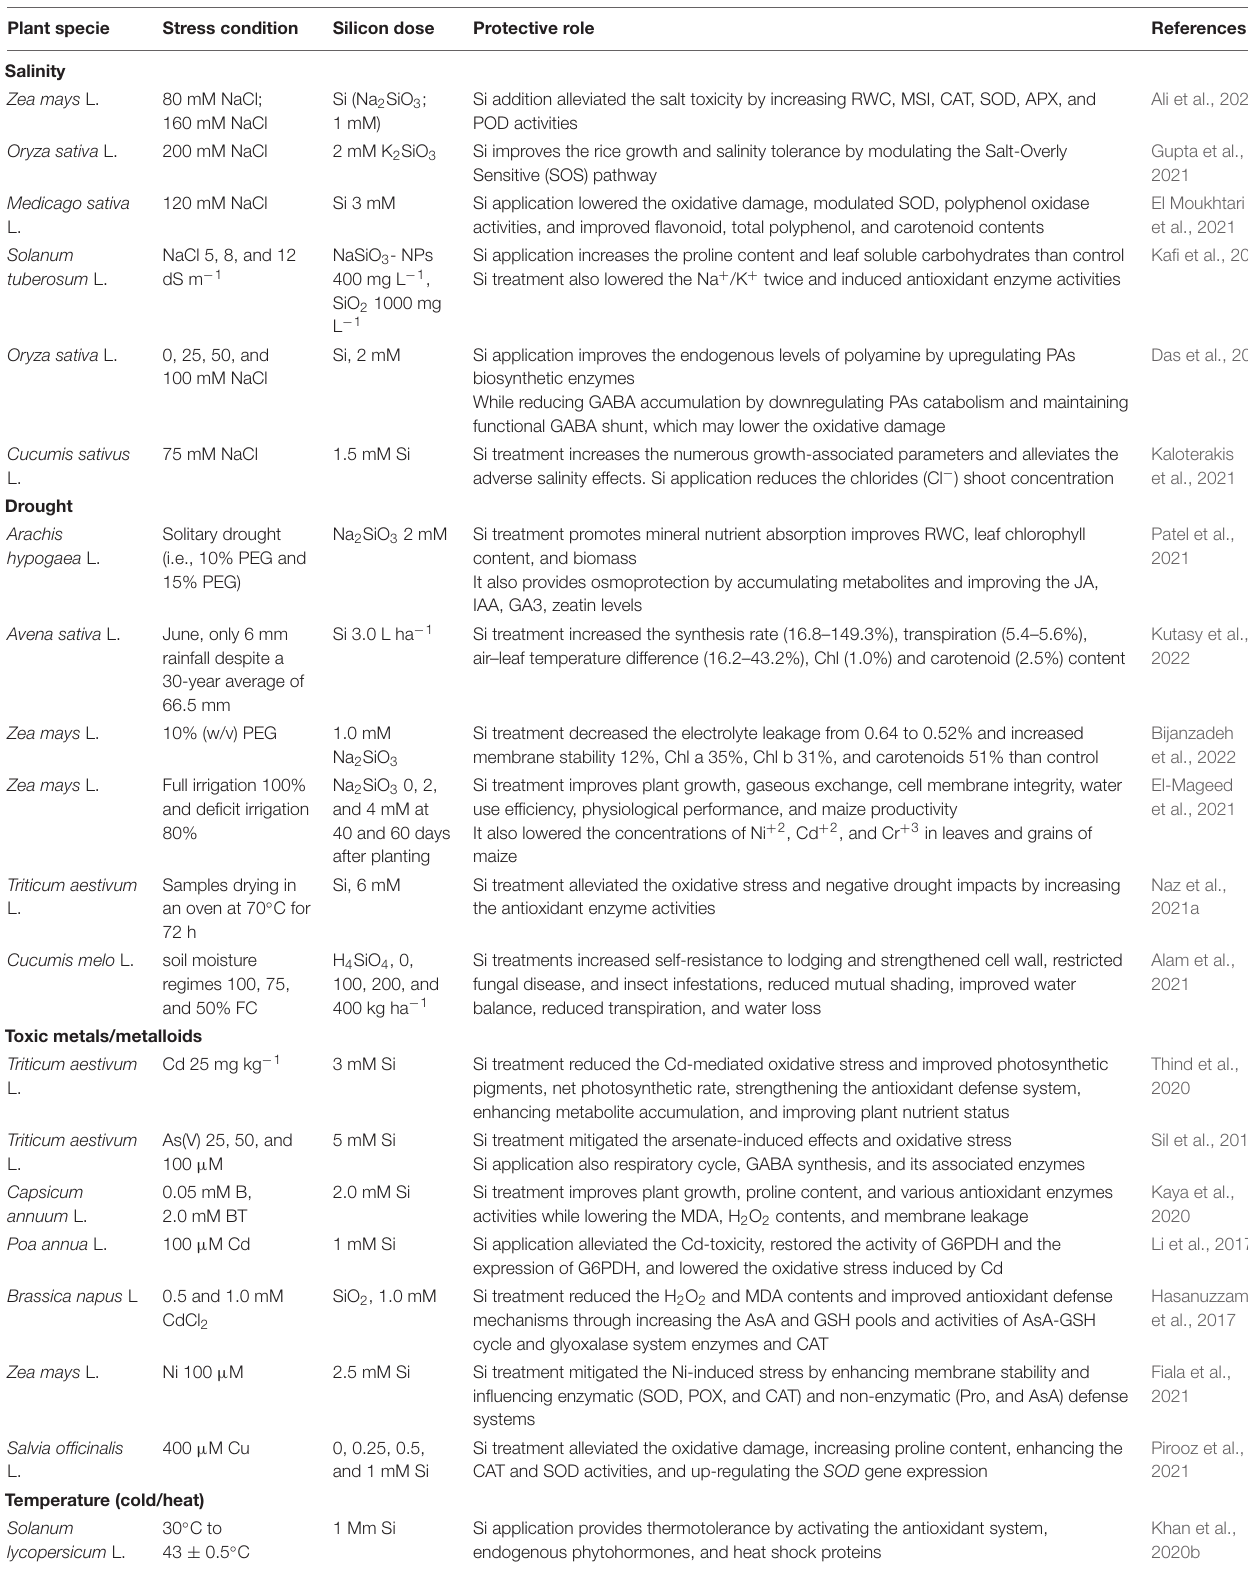
TABLE 2 | A summary of some recent reports on silicon-induced abiotic stress tolerance in crop